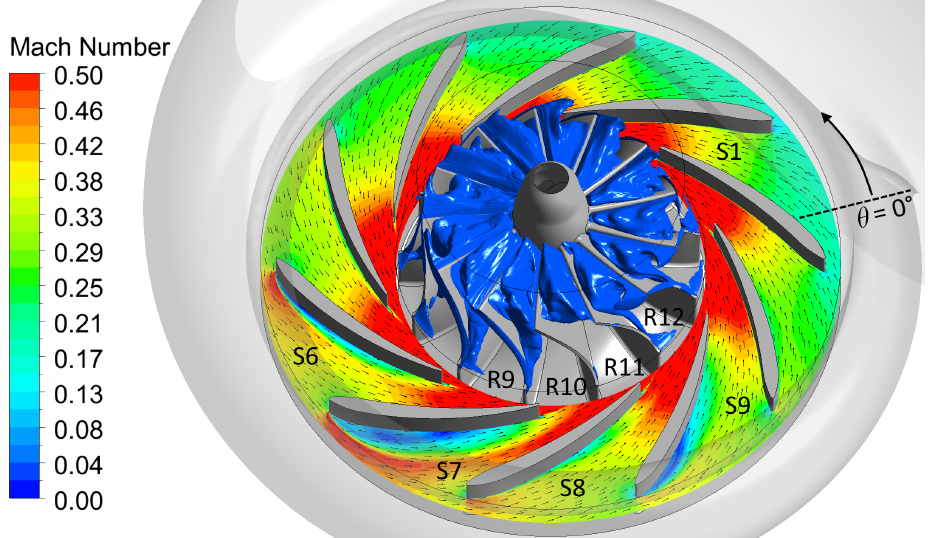
Figure 10. Mach contour and normalized tangential flow vectors at the stator mid span and isosur- faces of nucleation in the rotor for the design operating point at 80% relative humidity. Adapted from [12]. Copyright 2022